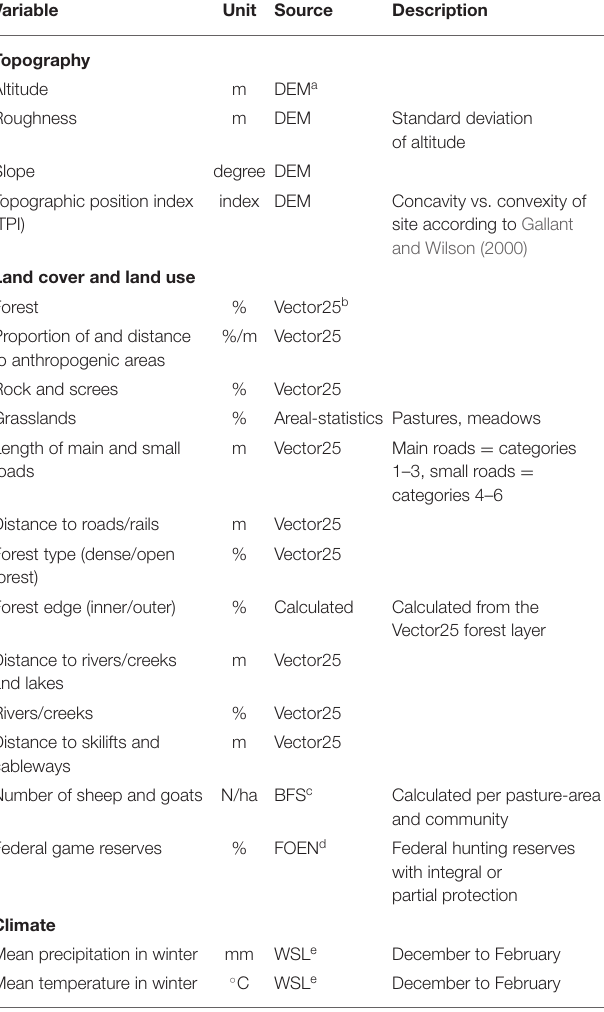
TABLE 2 | Environmental variables used to predict relative ungulate densities, extracted from buffer zones around the transects or circular moving windows of 50 ha (see section Material and Methods for more details).